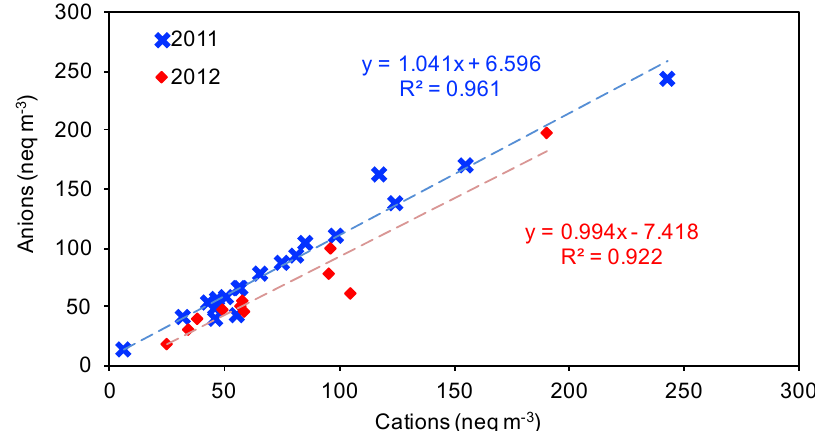
Figure 7. Linear correlations between the concentrations (expressed as neq m − 3 ) of cations and anions determined both during AREX2011 ( n = 19) and AREX2012 ( n = 14).